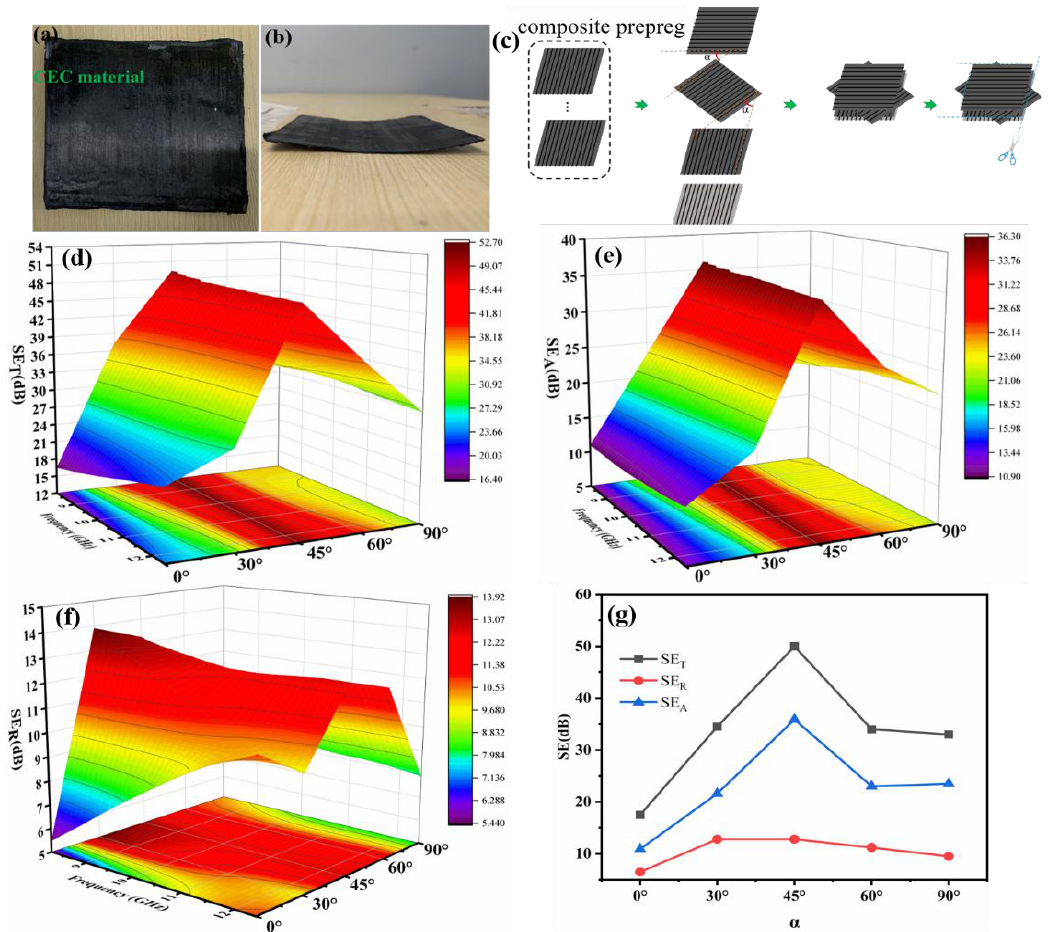
Figure 4. ( a , b ) Photographs of the cured CEC sample; ( c ) preparation method of the sample with different α of composite prepregs. Three-dimensional presentation of ( d ) SE T , ( e ) SE A , ( f ) SE R and ( g ) trend of variation of SE at 9 GHz of composites with different α .